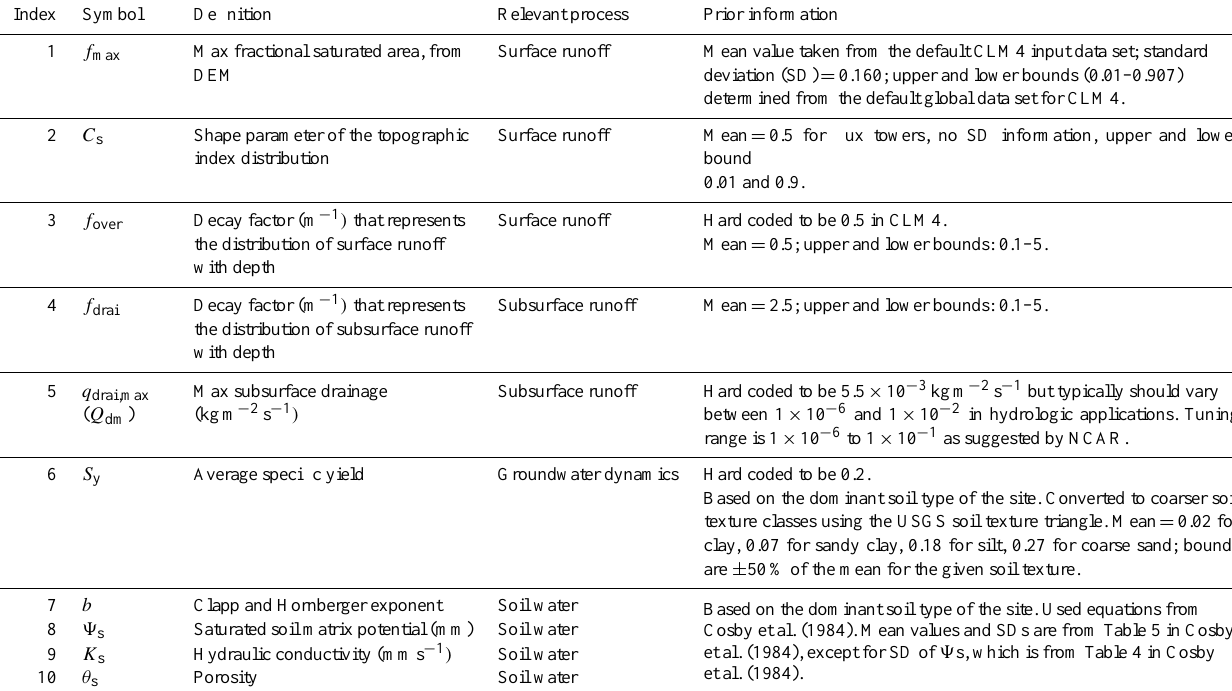
Table 1. Selected hydrologic parameters in CLM4 and their prior information (from Hou et al., 2012).